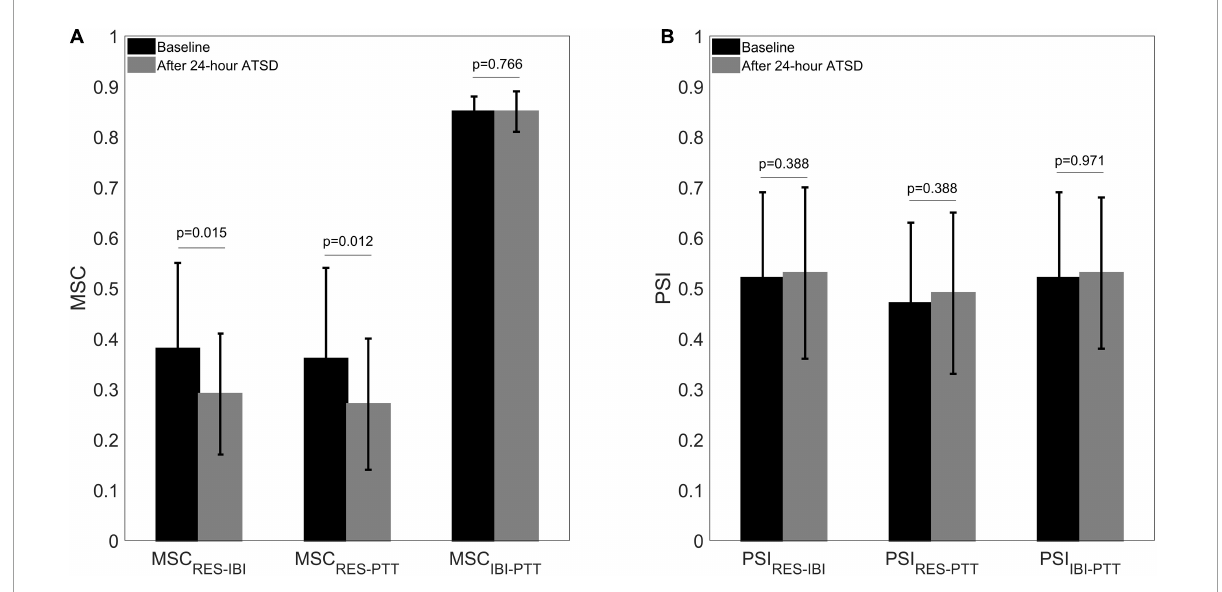
FIGURE5 (A) Cardiorespiratory, respiratory-cardiovascular, and cardiovascular magnitude squared coherence (MSC) as well as (B) phase synchronization index (PSI) before and after 24-h acute total sleep deprivation (ATSD) for healthy